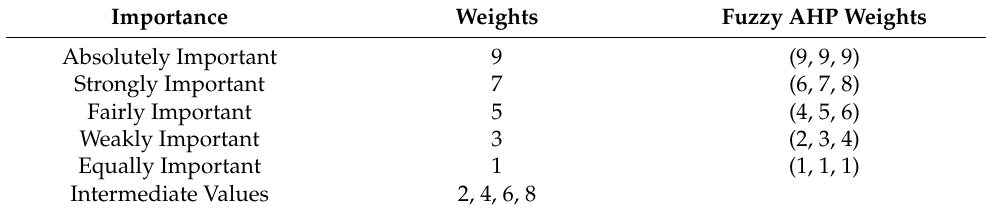
Table 1. Fuzzified Saaty’s scale